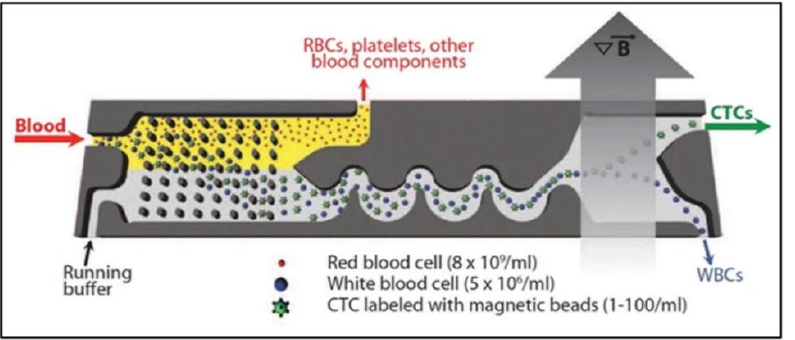
Figure 10. A view of particle sorting mechanism of white blood cells, red blood cells, and circulating tumor cells (CTCs) [128], Copyright 2018, Springer Open. tumor cells (CTCs) [128], Copyright 2018, Springer